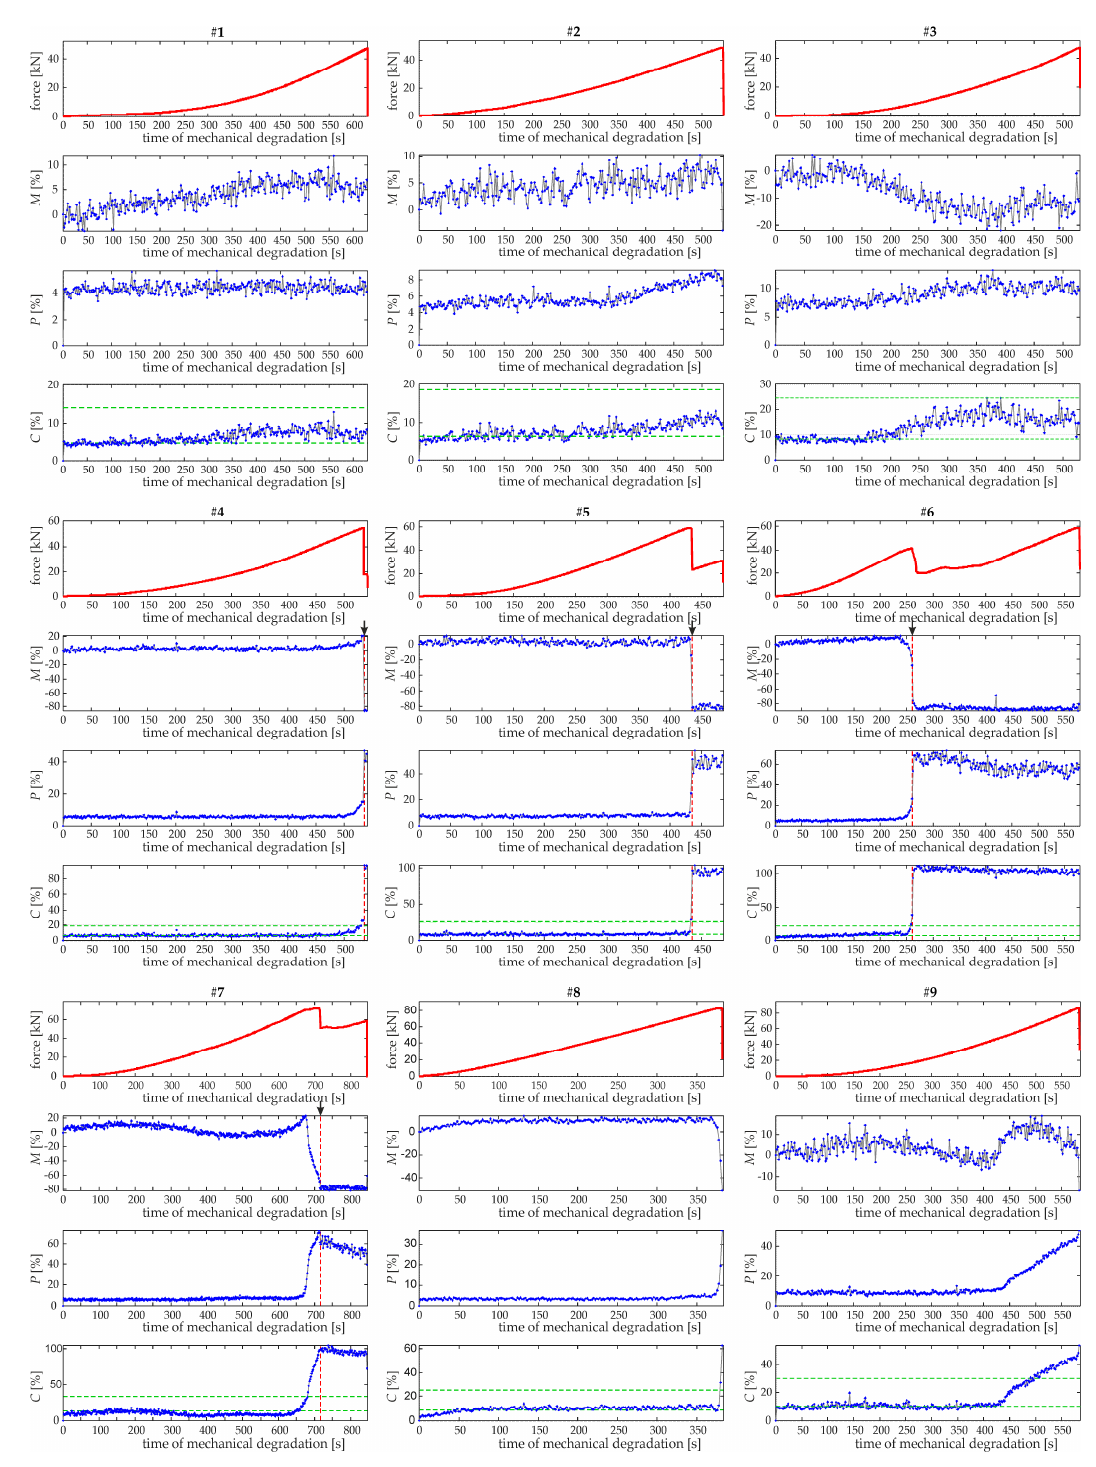
Figure 11. S&G metric errors (magnitude error M , phase error P , comprehensive error C ) during subsequent phases of degradation of push-out specimens ( #1 – #9 ).